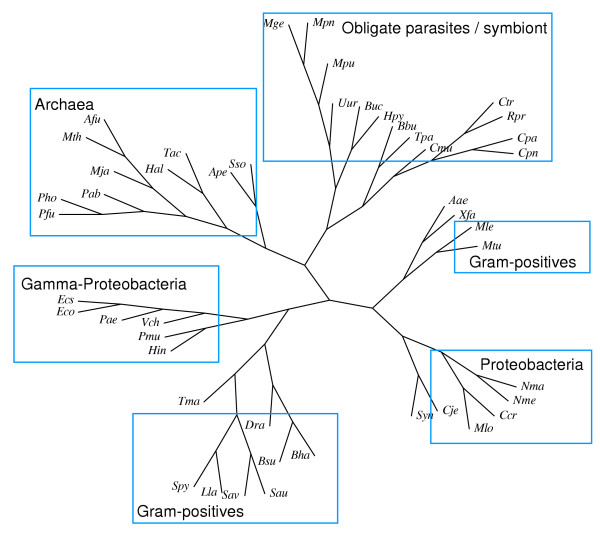
The pathway set based tree. The names and categories of organisms included in the tree are given in Additional file 1. The tree was drawn with the program TreeconW [35].